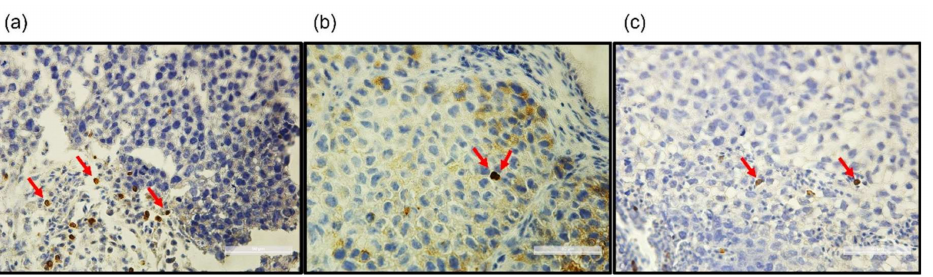
Figure 2. Representative examples of the immunohistochemical staining of the lymphocyte markersCD3 ( a ), CD4 ( b ) and CD8 ( c ), pointed by red arrow, for H460 tumor xenografted in ovo . Bar = 50 µ m.